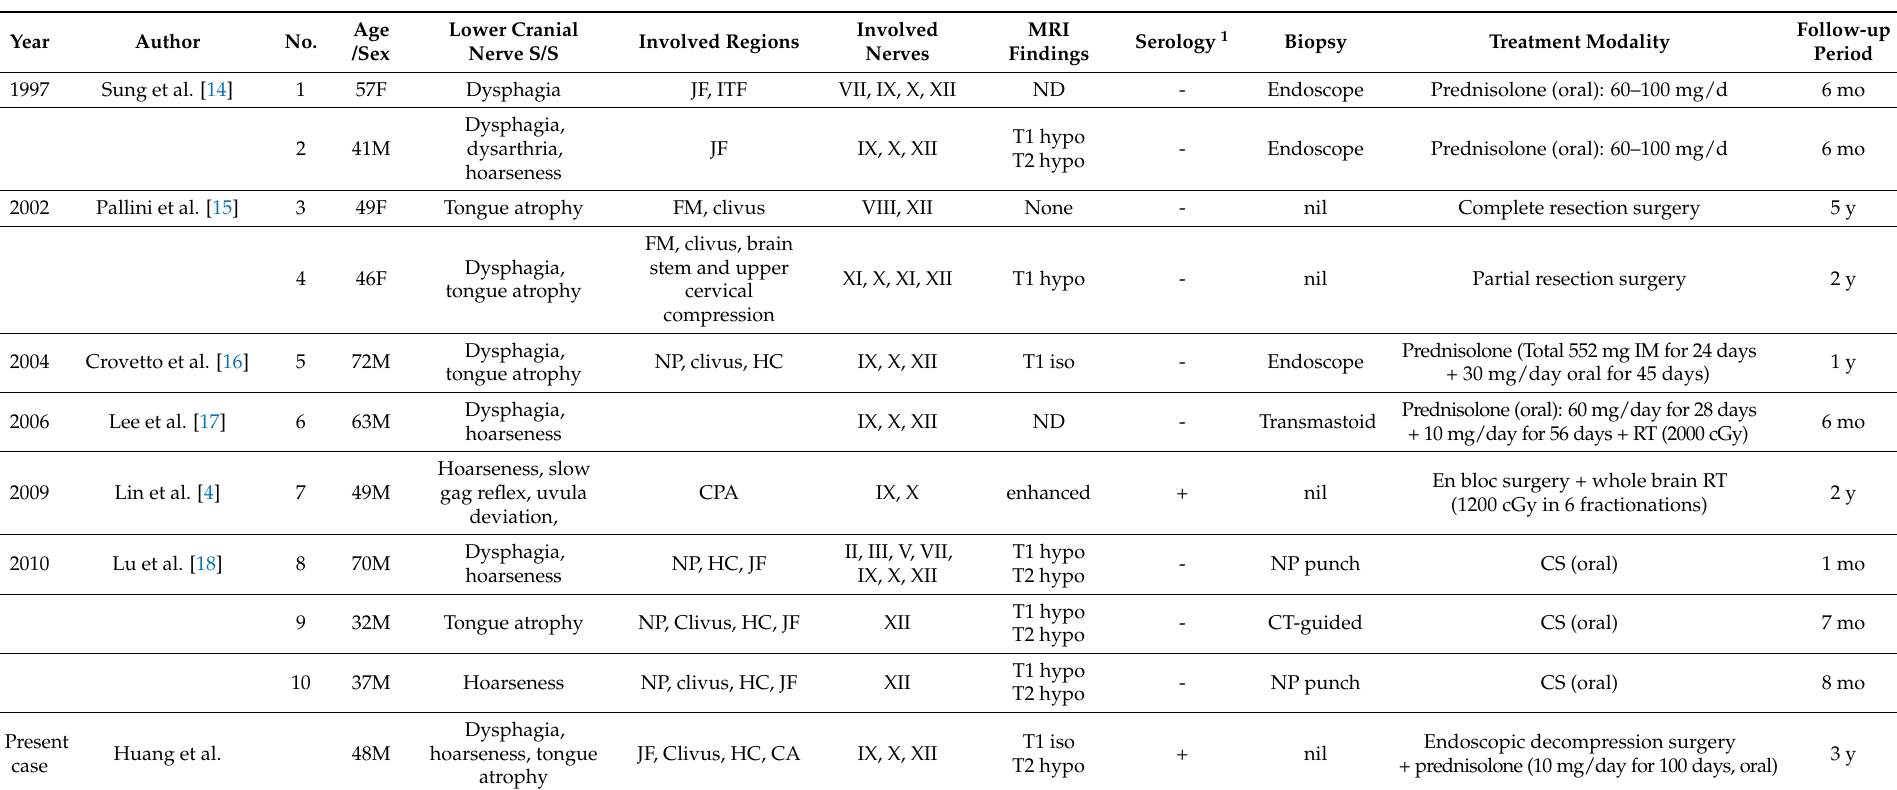
Table 1. Literature summary of demographic characteristics and treatment modality of inflammatory pseudotumor with lower cranial nerve